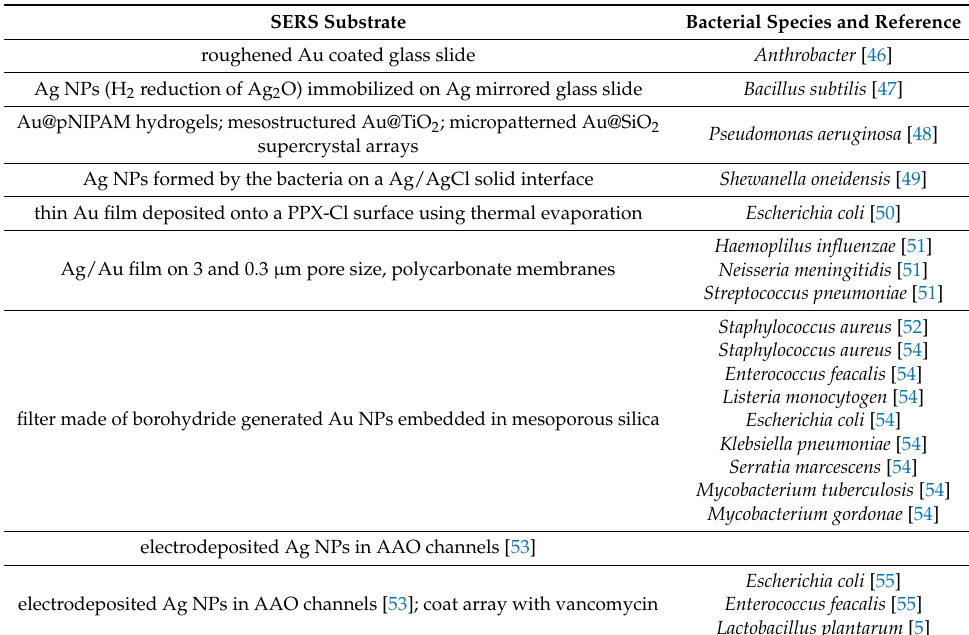
Table 2. Summary of bacteria detected by placing bacteria directly on a SERS-active surface that were discussed in this